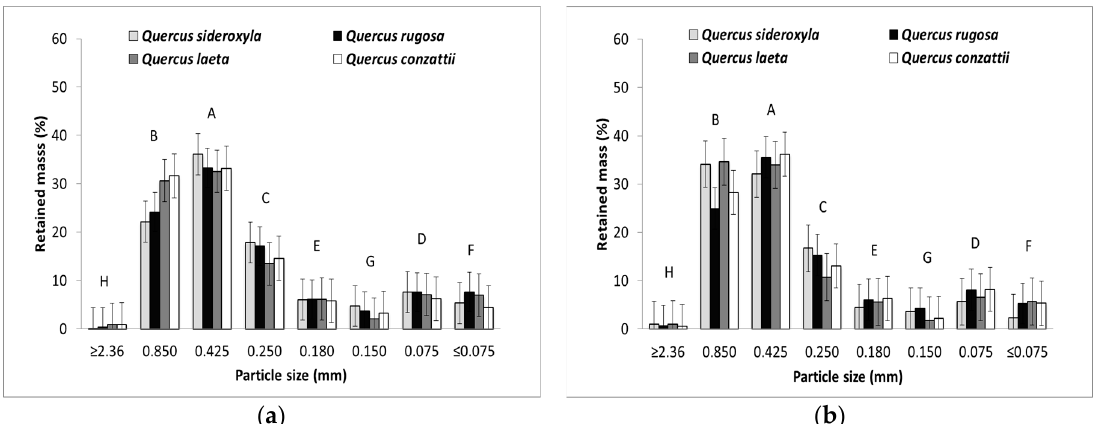
Figure 1. Sawdust granulometric distribution of four oak species: ( a ) barked; ( b ) debarked. (Bars with different letters correspond to statistically different relative mass; p < 0.05). Table 2. Normality test and statistical analysis of the granulometric distribution of sawdust of four oak species.